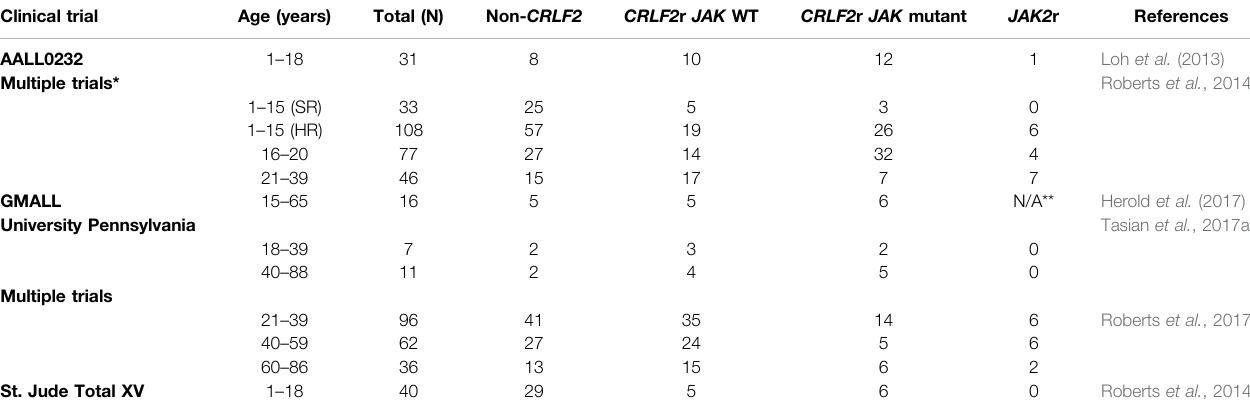
TABLE 1 | Frequency of JAK2 mutations and JAK2 rearrangements within Ph-like ALL. Prevalence of CRLF2 r/ JAK mutant and JAK2 r subtypes of Ph-like ALL compared with Ph-like ALL cases without CRLF2 overexpression. Clinical